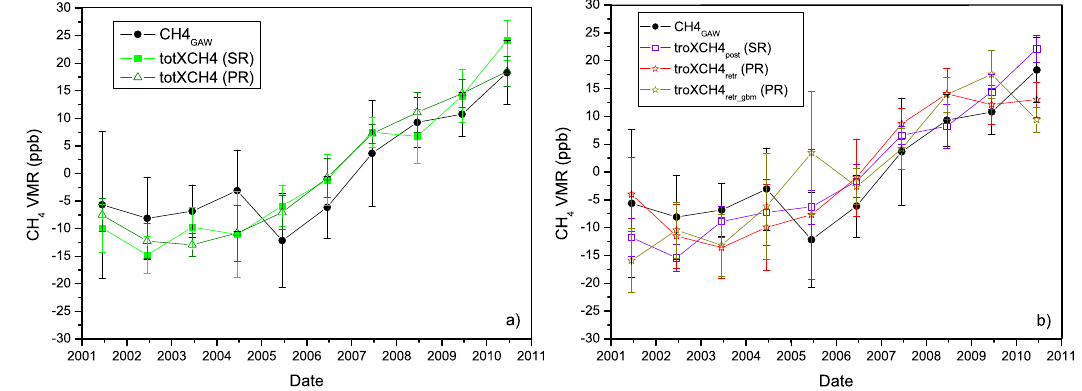
Fig. 11. Annual mean for the CH 4 in-situ (black dots) and the different FTIR products considering coincident data and centered at GAW zero. (a) total XCH 4 products: green squares for totXCH 4 from SR, and green dark open triangles for totXCH 4 from PR; (b) tropospheric XCH 4 products: violet open squares for troXCH 4 , red stars for troXCH 4 , and open dark yellow stars for troXCH 4 post retr correspond to the standard error of the mean [2 × STD/sqrt( N) ].